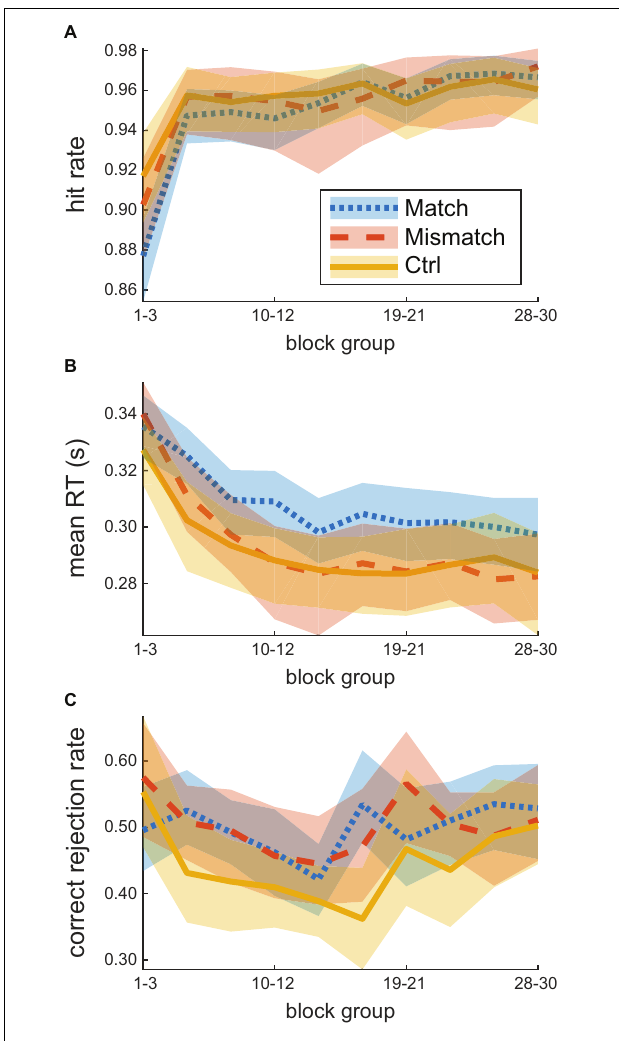
FIGURE 3 | Time-courses of average training task performance. Participants were assigned to the condition that aligned (match, n = 37) or misaligned (mismatch, n = 24) with their predominant regulatory focus (Ctrl: no-points control condition, n = 31). Performance is summarized with (A) hit rate, (B) 20% trimmed mean response time for go stimuli, and (C) correct rejection rate. Summaries are computed over groups of three consecutive blocks. Shading shows a bootstrapped 95% confidence